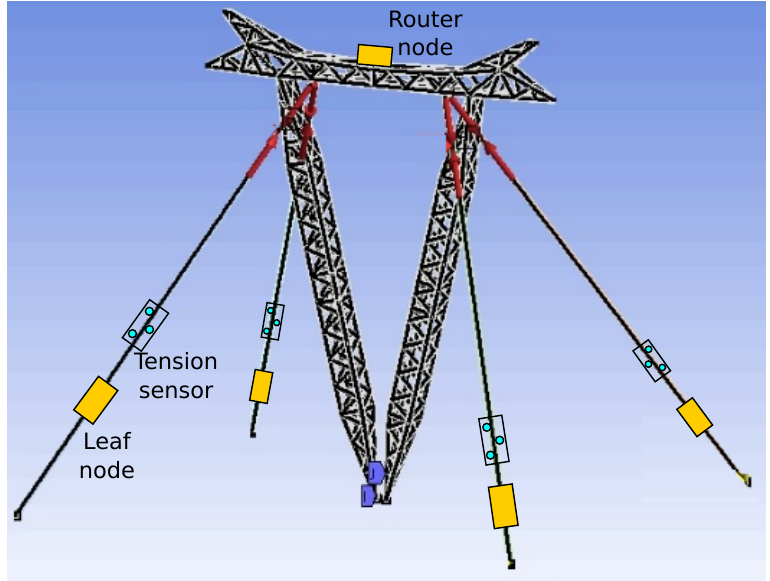
Figure 3. Virtual model of an guyed-V steel lattice tower and the placement of the devices and sensors.